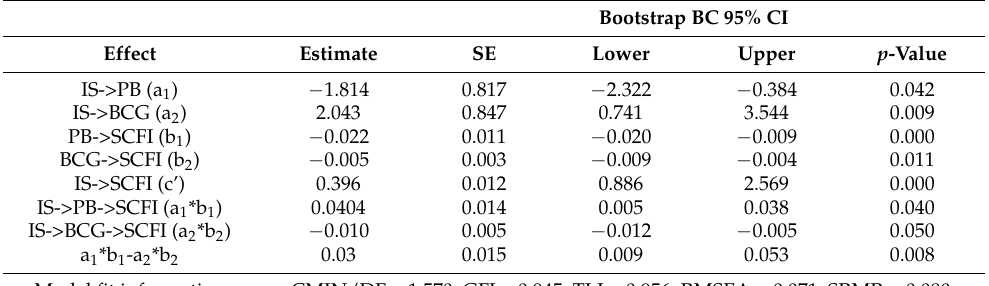
Table 5. Results of mediation analysis after